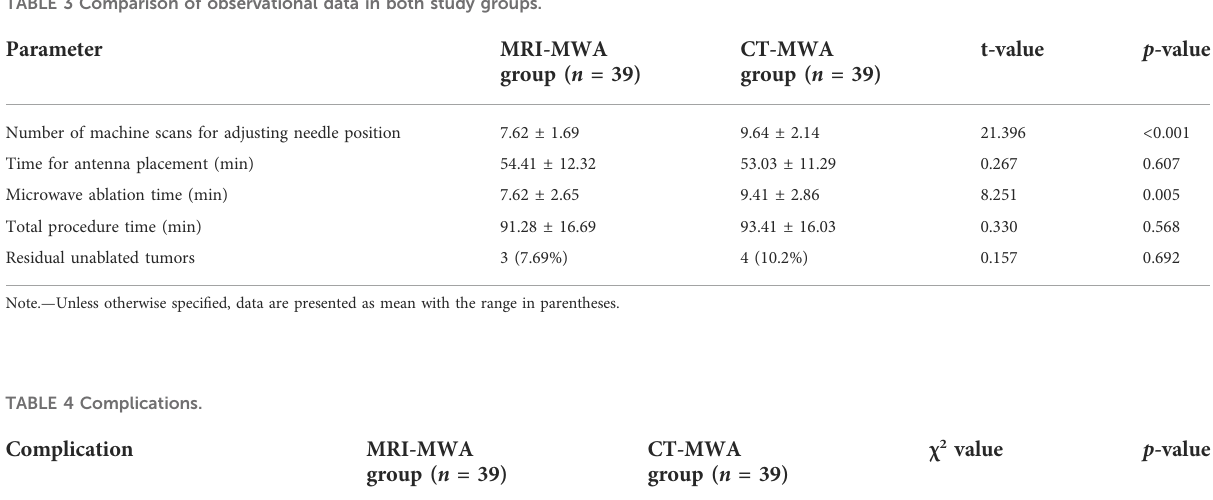
TABLE 3 Comparison of observational data in both study